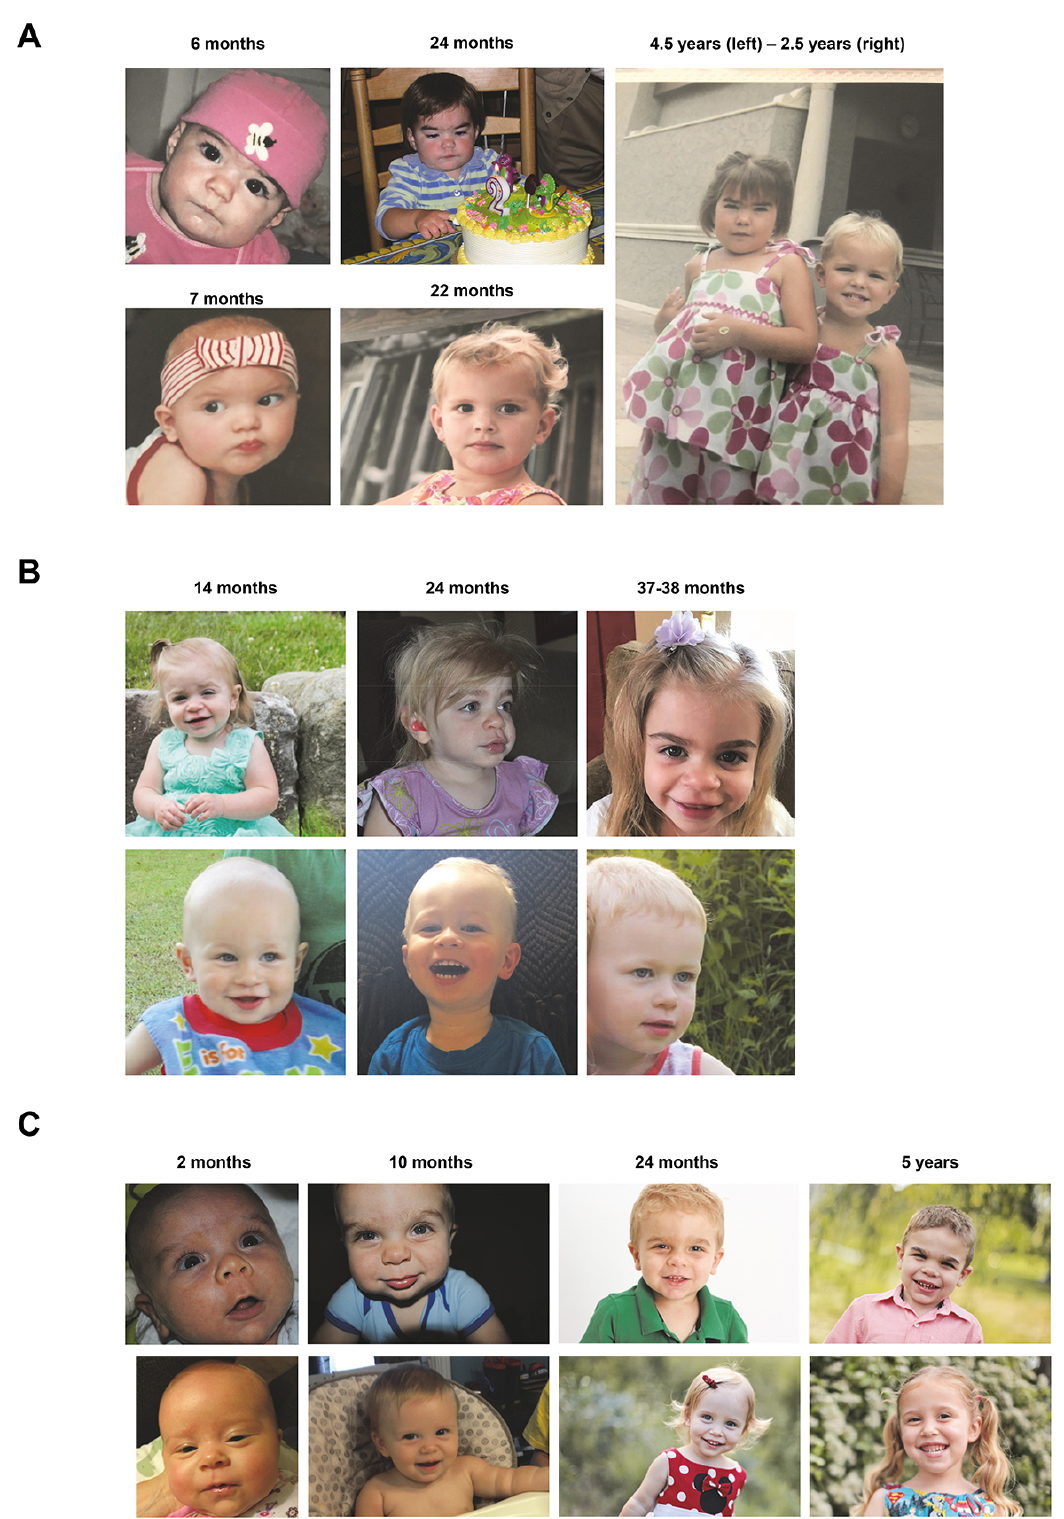
Figure 1. Early facial coarsening and presence of synophrys in MPS IIIB patients. (A) Left: progression of an MPS IIIB patient (upper panel) in comparison with her unaffected sibling (lower panel) at comparable ages. Right: comparison of the MPS IIIB patient (left) with her unaffected sibling (right) at different ages. (B & C) Progression of two MPS IIIB patients (upper panels) in comparison with their age-matched unaffected siblings (lower